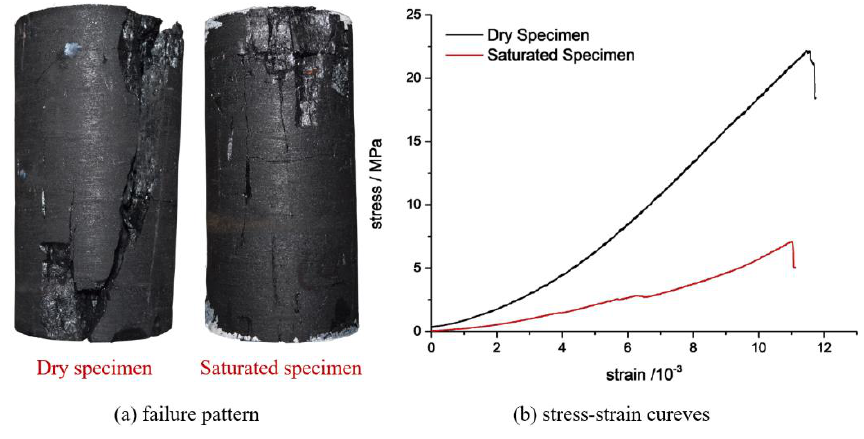
Figure 6. ( a ) failure patterns and ( b ) stress-strain curves of dry and saturated coal specimens. Table 2. Macro-mechanical properties of coal specimen in laboratory experiments.